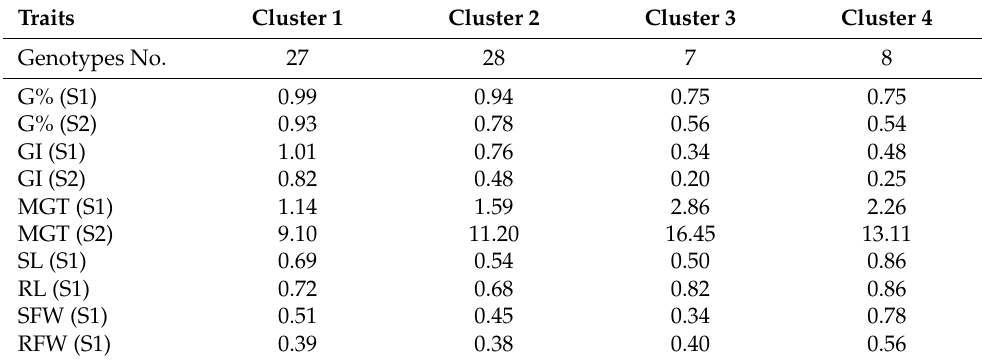
Table 7. Mean values of stress tolerance index for different germination and seedling traits under different salt concentrations of the four clusters of 70 barley genotypes.